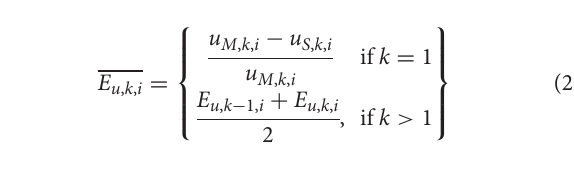
k = 1, the adjustment factor, E u , k , i , is the mean of E u , k , i and E u , k − 1, i